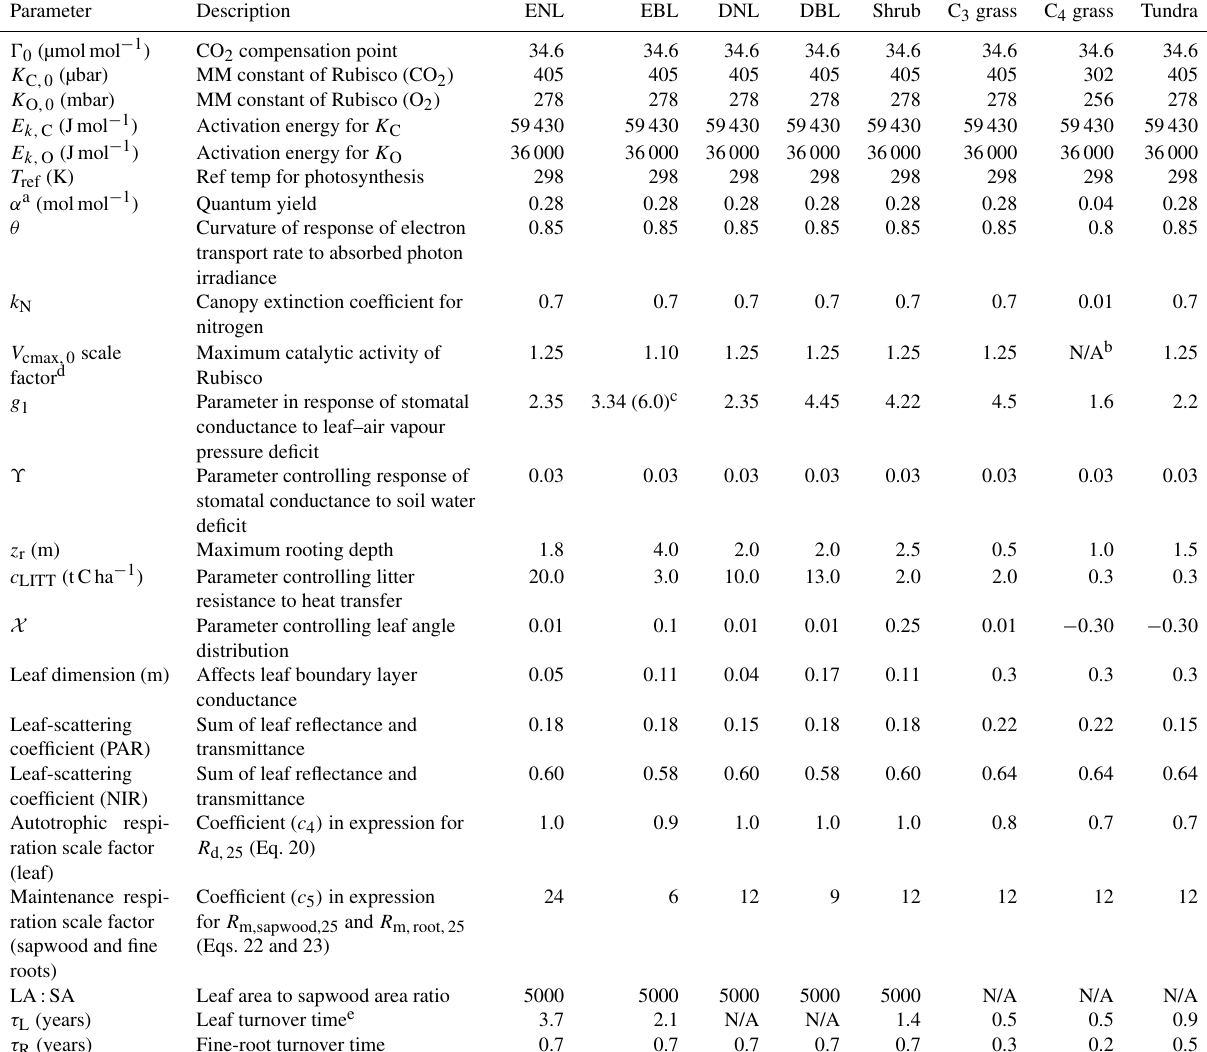
Table A1. CABLE biophysics and CASA-CNP biogeochemistry parameters for evergreen needle-leaf (ENL), evergreen broadleaf (EBL), deciduous needle-leaf (DNL), deciduous broadleaf (DBL), shrub, C 3 grass, C 4 grass and tundra plant functional types. Parameter